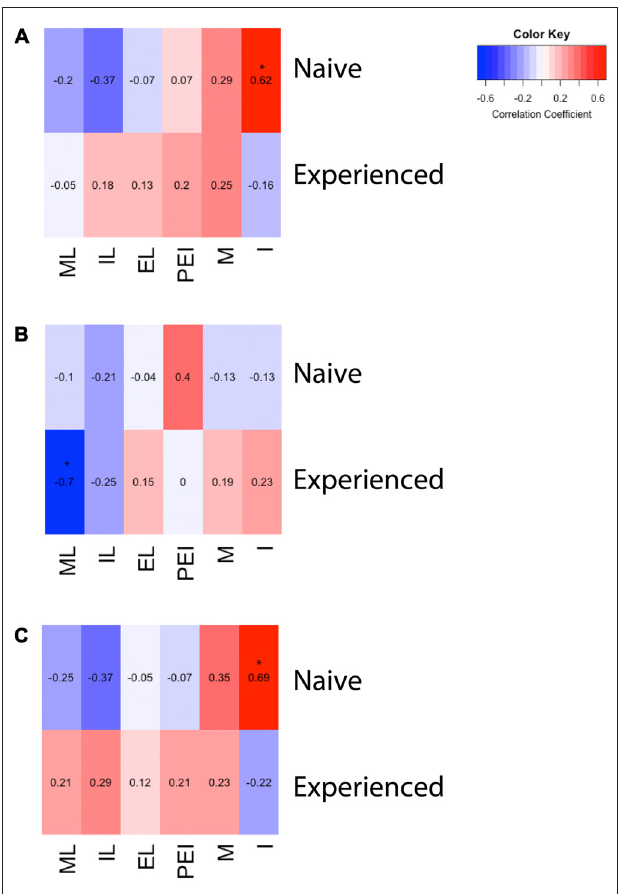
FIGURE 3 | Heat maps depicting correlation between sexual behavior and D2- or Fos-immunoreactivity in the mPOA of male rats. (A) There was a significant positive correlation between the number of intromissions and Fos immunoreactivity in naïve animals copulating for the first time. (B) There was a significant negative correlation between latency to mount and the number of D2 immunopositive cells in sexually experienced animals. (C) There was a significant positive correlation between the number of intromissions and percent of D2 cells that contained Fos in naïve animals copulating for the first time. (ML, mount latency; IL, intromission latency; EL, ejaculation latency; PEI, post ejaculation interval; M, mounts; I, intromissions).